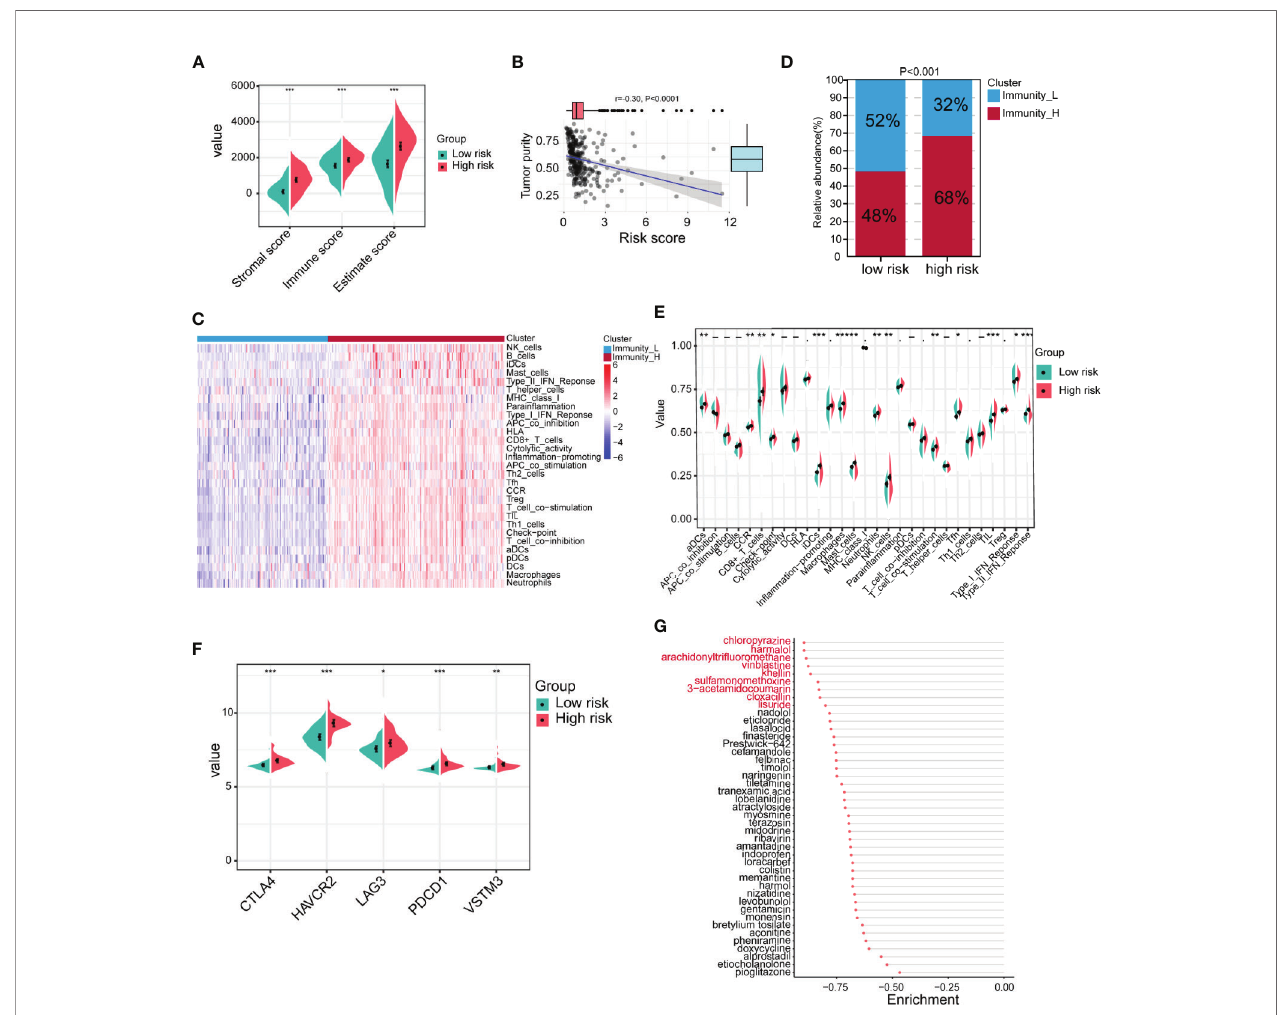
FIGURE 7 | Identi fi cation of the immune characteristics of the high- and low-risk groups. (A) Differences in the TME between the high- and low-risk groups were identi fi ed (high-risk n = 138, low-risk n = 162; Student ’ s t-tests). (B) Correlation analysis of tumor purity and risk scores (Pearson correlation coef fi cient). (C) Chi- square analysis of high- and low-risk groups and different immune clusters (Immunity_L n = 128, Immunity_H n = 172 Chi-square test). (D) The gastric cancer samples were divided into two immune clusters by ssGSEA based on 29 immune signatures (Immunity_L n = 128, Immunity_H n = 172; chi-square test). (E) Analysis of differences in the expression of 29 immune signatures in the high- and low-risk groups (Student ’ s t-tests). (F) Expression analysis of immune checkpoints in different risk groups (high-risk n = 138, low-risk n = 162; Student ’ s t-tests). (G) The Connectivity Map (CMap) database was used to screen potential drugs for the treatment of high-risk patients. Drugs marked in red represent enrichment ≤ 0.8. Data for (A – G) are from the GSE62254 dataset. Signi fi cant difference between the two groups: *P < 0.05; **P < 0.01; ***P <